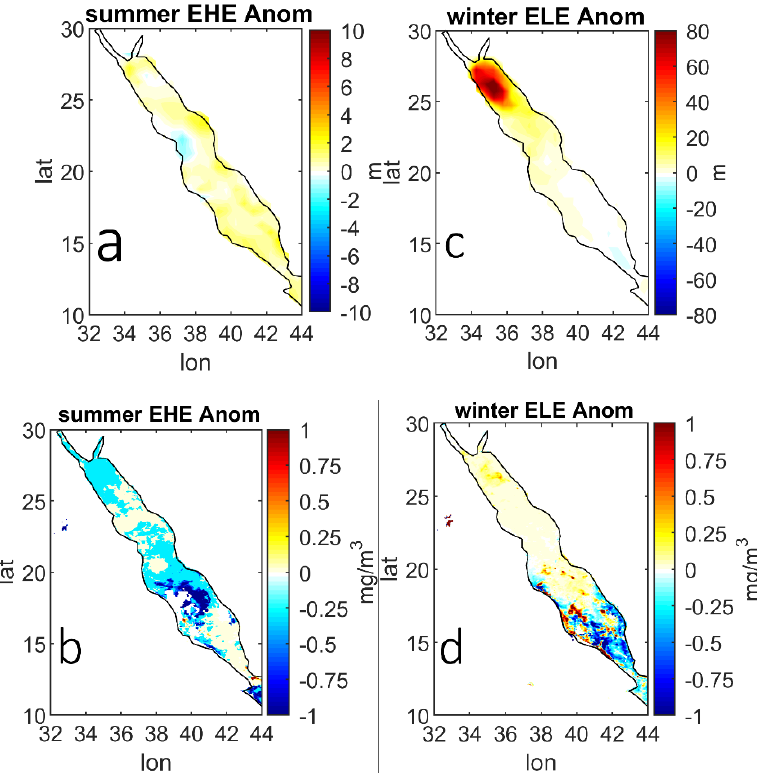
Figure 7. Composite anomalies of the mixed layer depth in m ( a ) and Chl-a concentration in mg / m 3 ( b ) for EHEs. Same for ( c ) and ( d ) but for